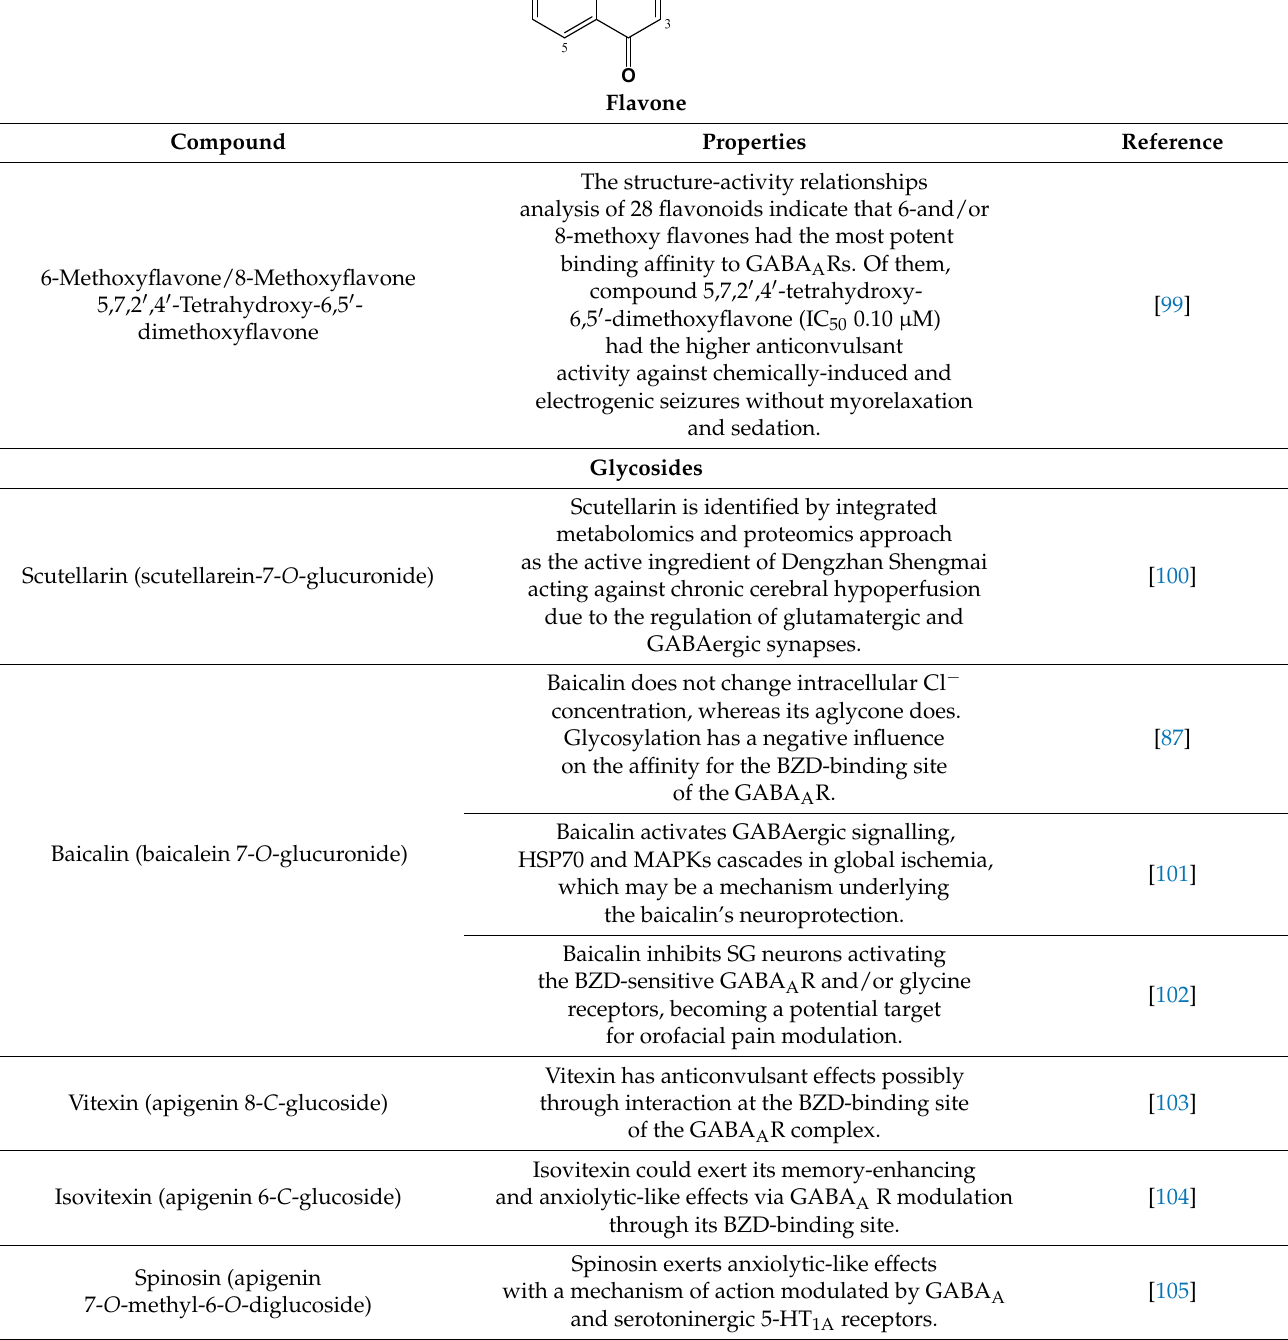
Table 2. Flavones with relevant GABAergic effects. Aβ (β-amyloid), APP (amyloid precursor Table 2. Cont.